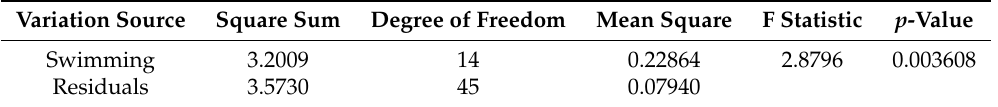
Table 7. ANOVA for